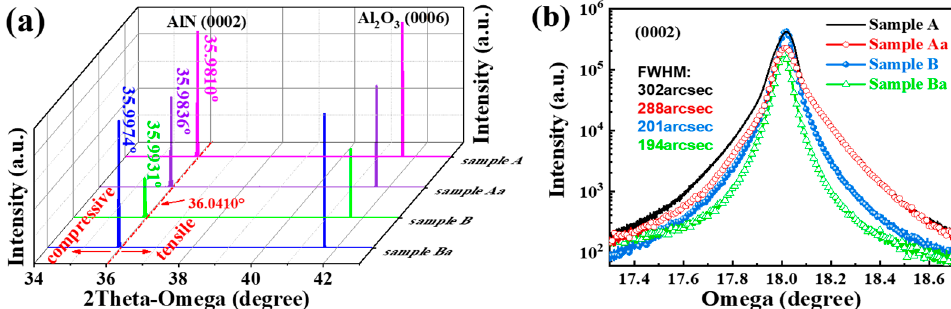
Figure 4. ( a ) The 2 θ - ω scan of AlN films by X-ray diffraction (XRD). ( b ) Symmetric (0 0 2) rocking curves of AlN epilayer with different substrates before and after annealing. Table 2. The structural parameters and dislocation density values obtained by XRD of the samples. Sample